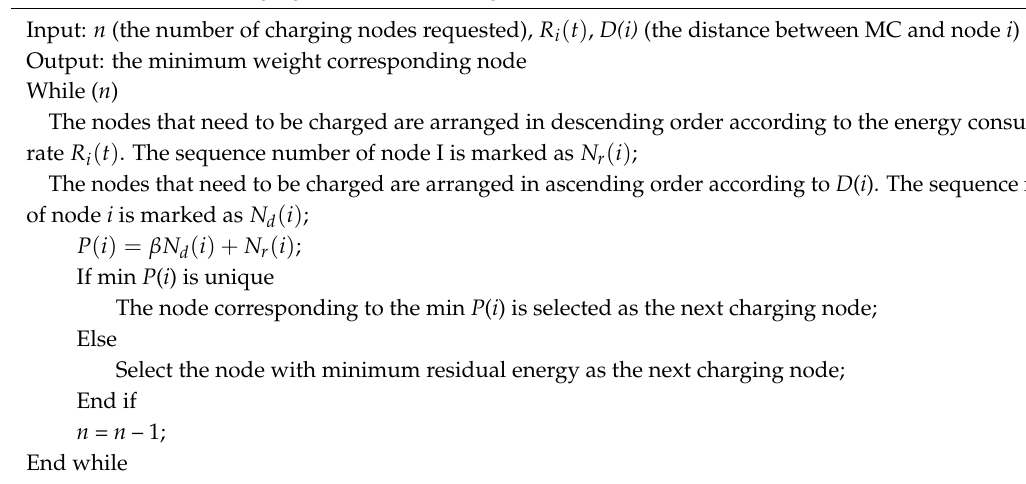
Algorithm 1 Next Charging Node Selection